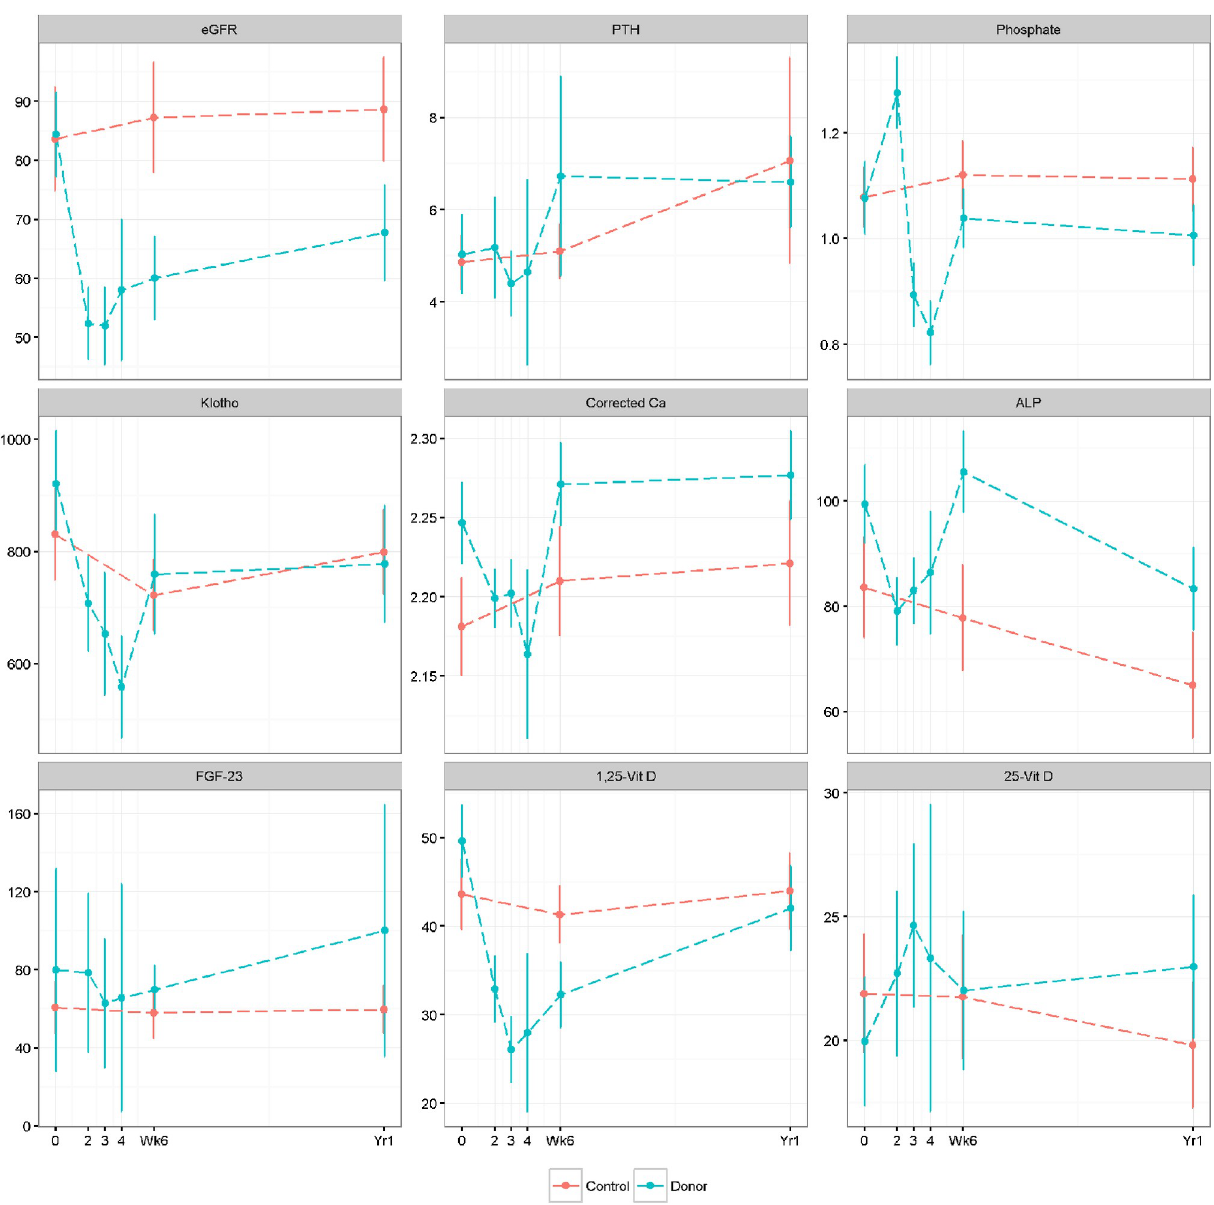
Fig 2. Changes in biochemical parameters over time. Legend: Changes in biochemical parameters from baseline at days 1, 2 and 3, 6 weeks and 12 months after donation in Donors (blue) and at 6 weeks and 12 months in Controls (red). Donation resulted in a marked and sustained reduction in eGFR (ml/min/1.73m 2 ) (A), a striking increase followed immediately by a decrease in phosphate (C) despite a late and non significant change in intact PTH (pmol/l) (B) and no significant change in FGF-23 (RU/ml) (G). Klotho (pg/ml) reduced significantly immediately after donation and remained below baseline (D). Corrected calcium (mmol/L) reduced (E) in parallel to changes in 1,25-dihydroxyvitamin D (ng/ml) (H). Dashed lines illustrated mean or median, solid lines represent SD or